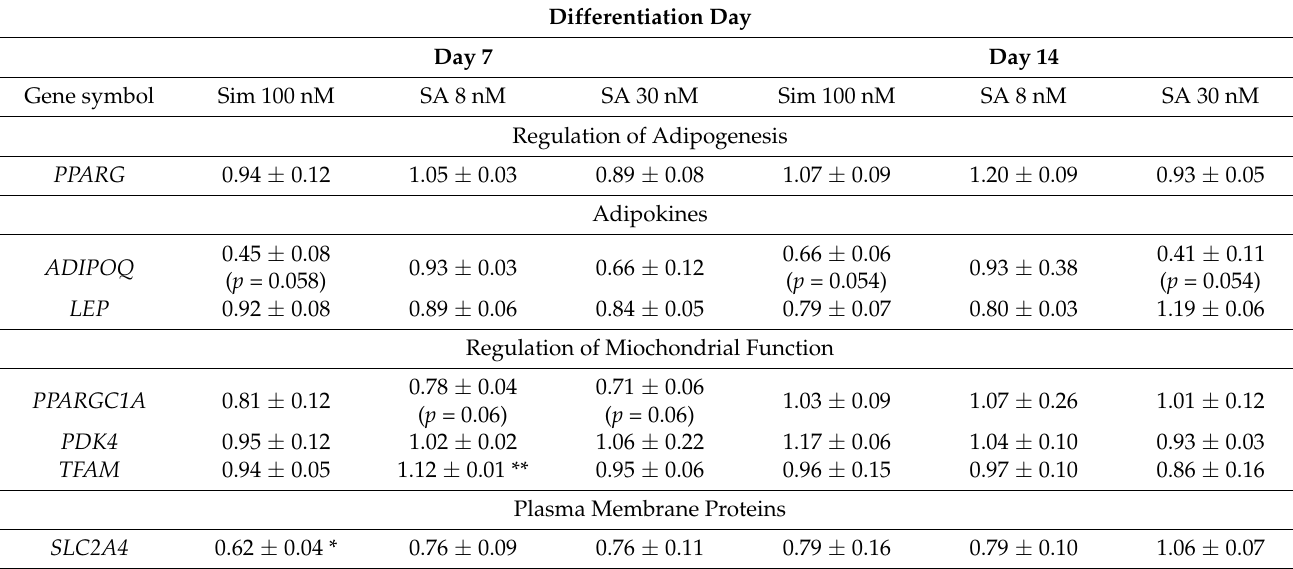
Table 6. Fold change in gene expression in SGBS adipocytes differentiated in the absence or presence simvastatin (Sim) and simvastatin acid